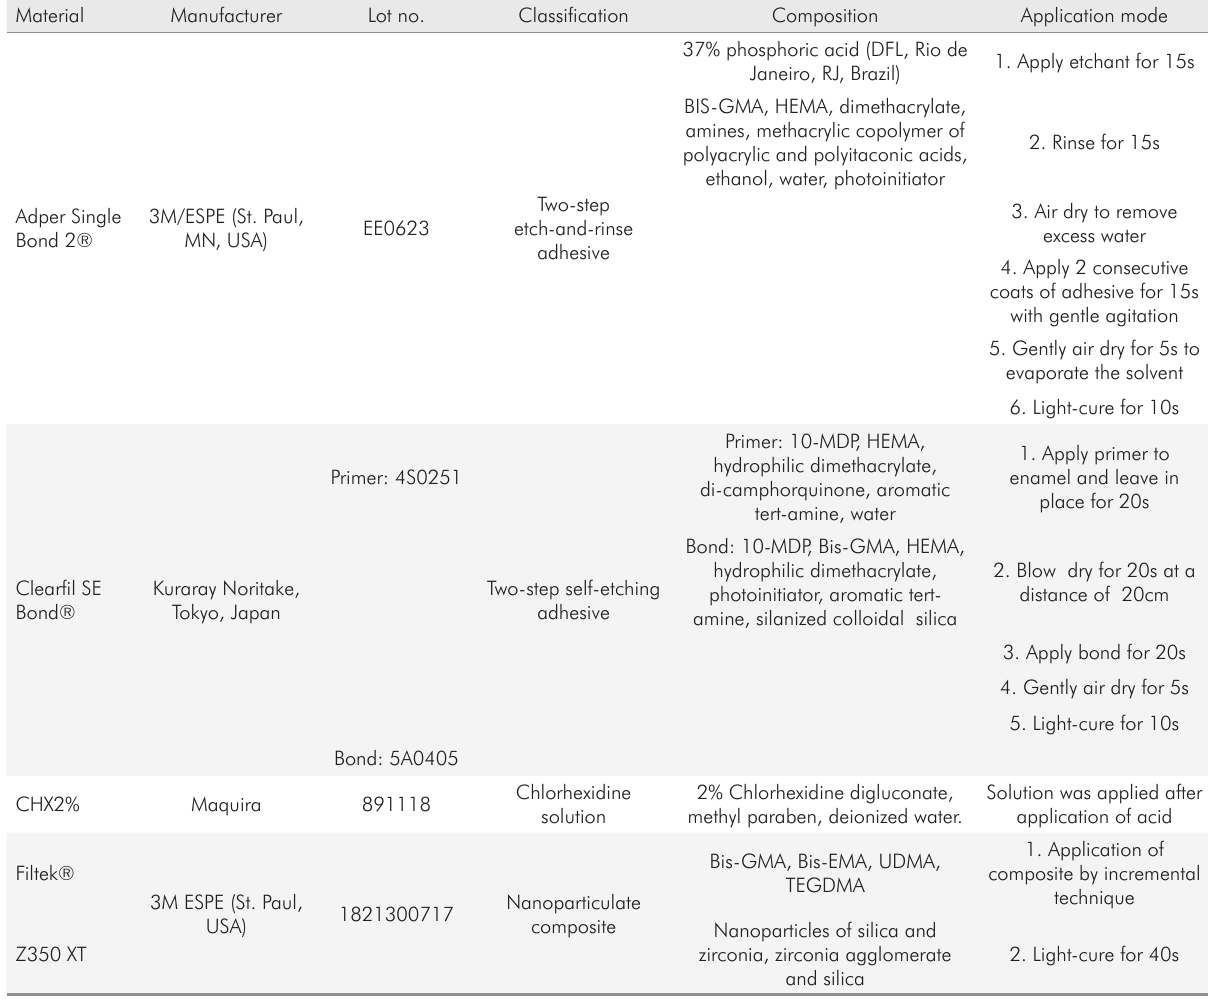
Table 1. Materials used in the study